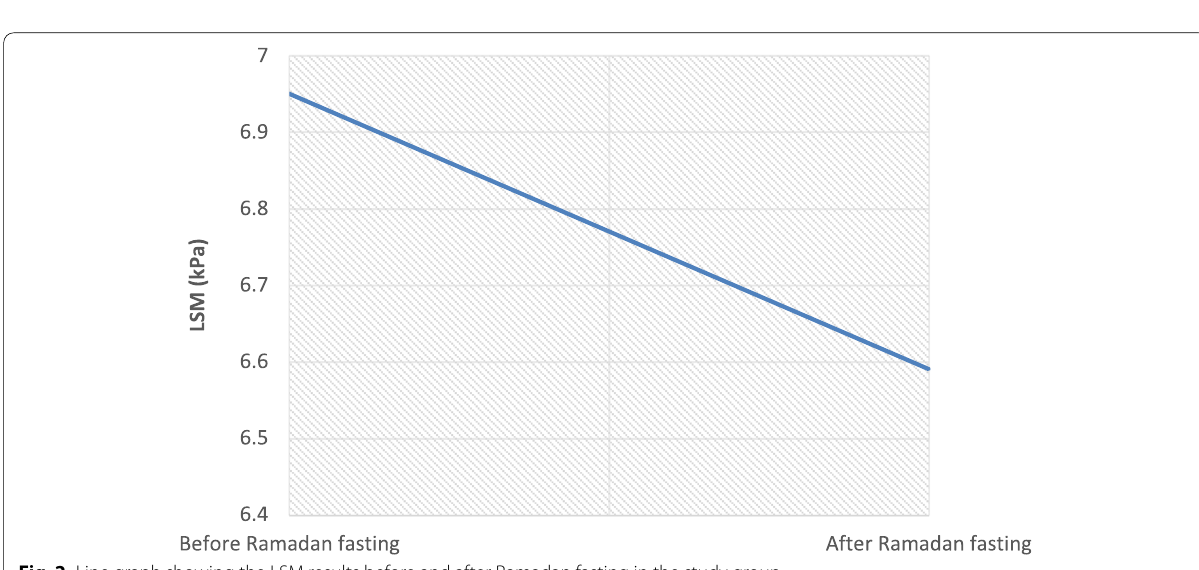
Fig. 2 Line graph showing the LSM results before and after Ramadan fasting in the study group